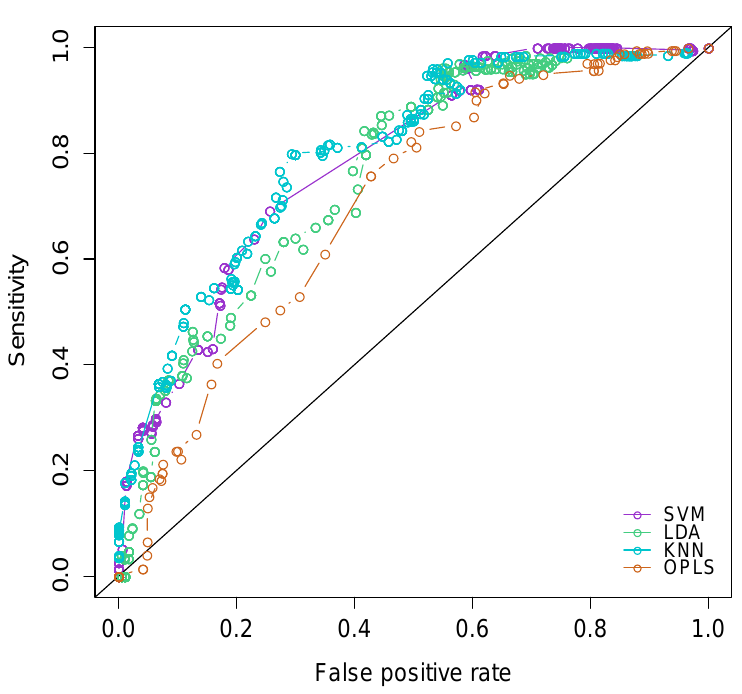
Figure 2. ROC curves displaying the comparison of the classification performance of four different algorithms with respect to sleep apnea severity (apnea–hypopnea index, AHI). The algorithms included support vector machine (SVM), linear discriminant analysis (LDA), k -nearest neighbour (KNN) and orthogonal partial least